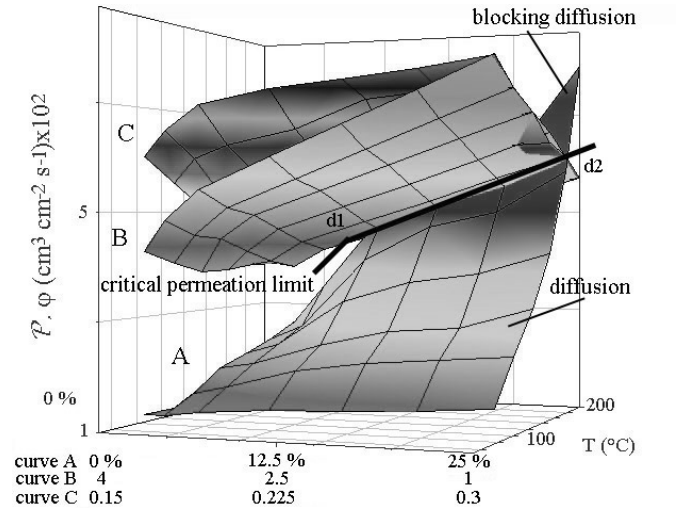
Figure 3. Permeability and flux. Effects of temperature and: Ag wt % (curve A), support thickness l mm for r : 0.25 µ m (curve B), support porosity ( ε rø − 1 ) µ m for l : 1 mm (curve C), line d: limit of critical